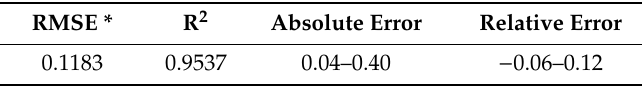
Figure 10. Performance prediction verification. Table 4. Error analysis of prediction model.